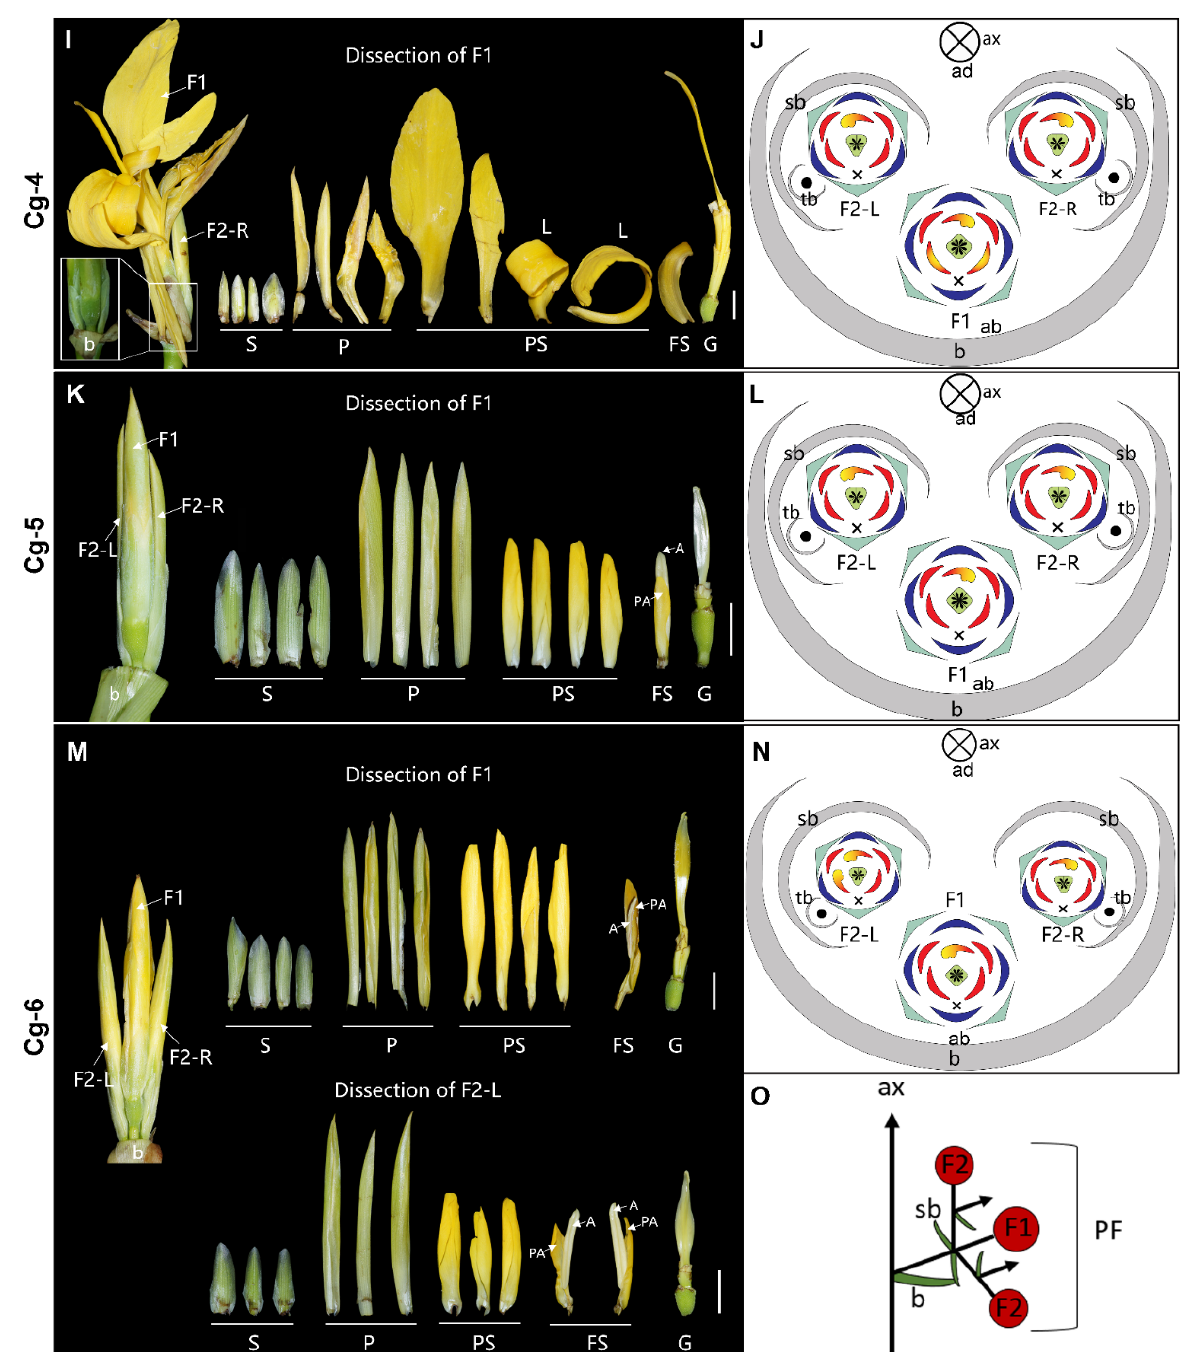
Figure 7. 3-flowered cyme. ( A ) Photograph and ( B ) diagram of the partial inflorescence of Ci-5. ( C ) Photograph and ( D ) diagram of the partial inflorescence of Cg-1. ( E ) Photograph and ( F ) diagram of the partial inflorescence of Cg-2. ( G ) Photograph and ( H ) diagram of the partial inflorescence of Cg-3. ( I ) Photograph and ( J ) diagram of the partial inflorescence of Cg-4. ( K ) Photograph and ( L ) diagram of the partial inflorescence of Cg-5. ( M ) Photograph and ( N ) diagram of the partial inflorescence of Cg-6. ( O ) Longitudinal scheme of the 3-flowered cyme. In unopened flowers, the characteristics defining the labellum have not developed, thus the labellum’s position is not indicated in corresponding figures ( C – H , K – N ). F2-L, the left secondary flower; F2-R, the right secondary flower. Bars = 1 cm.